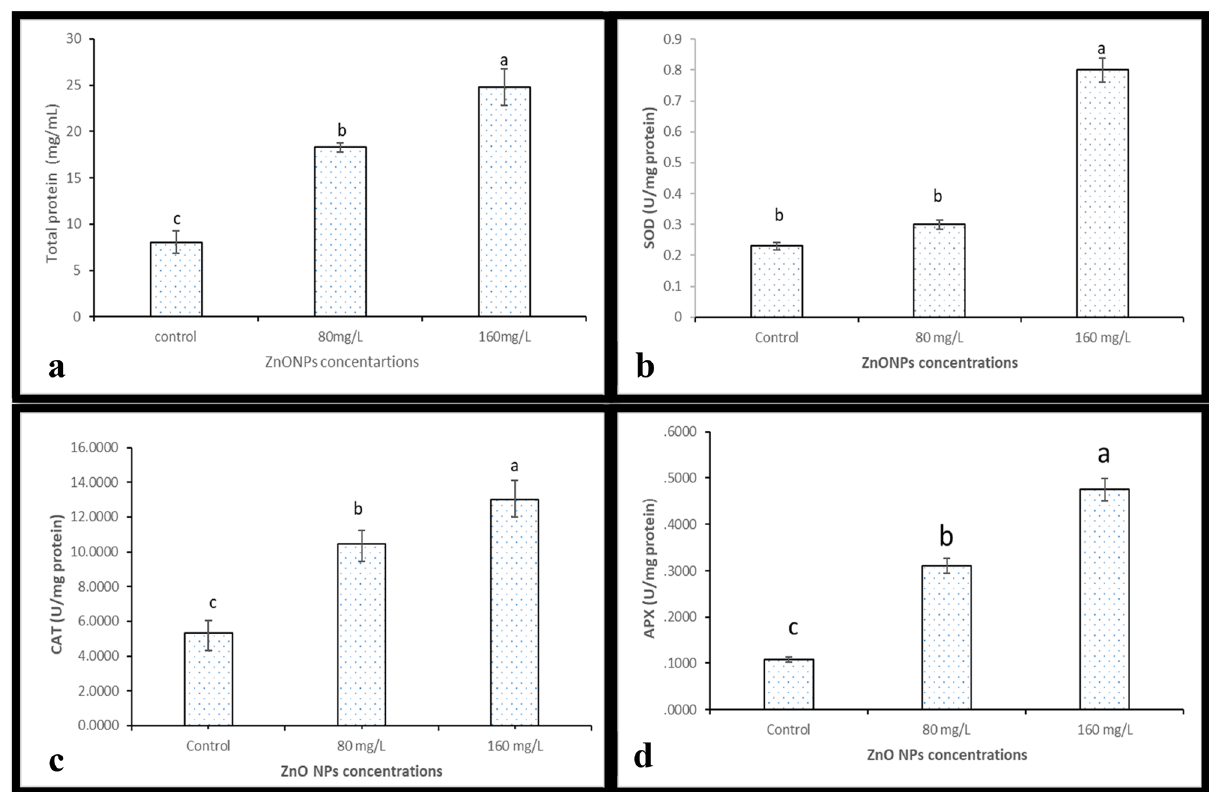
Figure 3. ( a ) Total protein contents under different concentration of ZnO NPs ( b ) SOD activity under different concentrations of ZnO NPs ( c ) CAT activity under different concentrations of ZnO NPs and ( d ) APX activity under different concentrations of ZnO NPs.